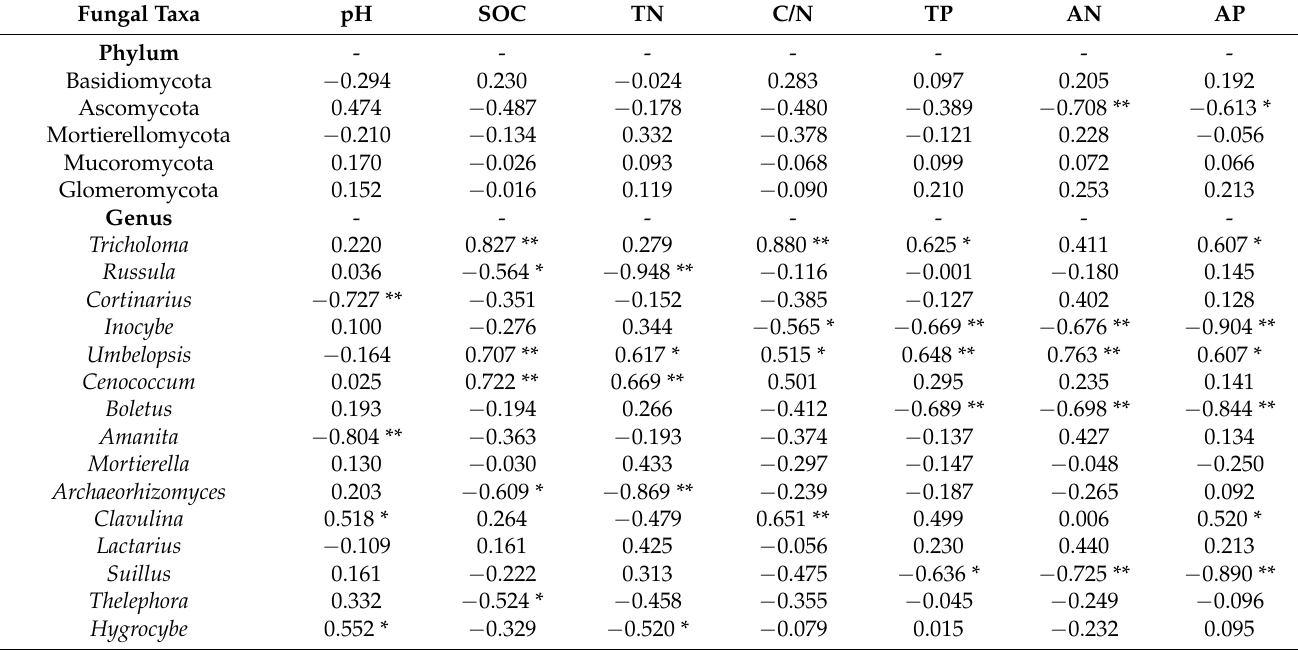
Table 5. Person’s rank correlations between the relative abundances of dominant bacteria taxa and soil physicochemical